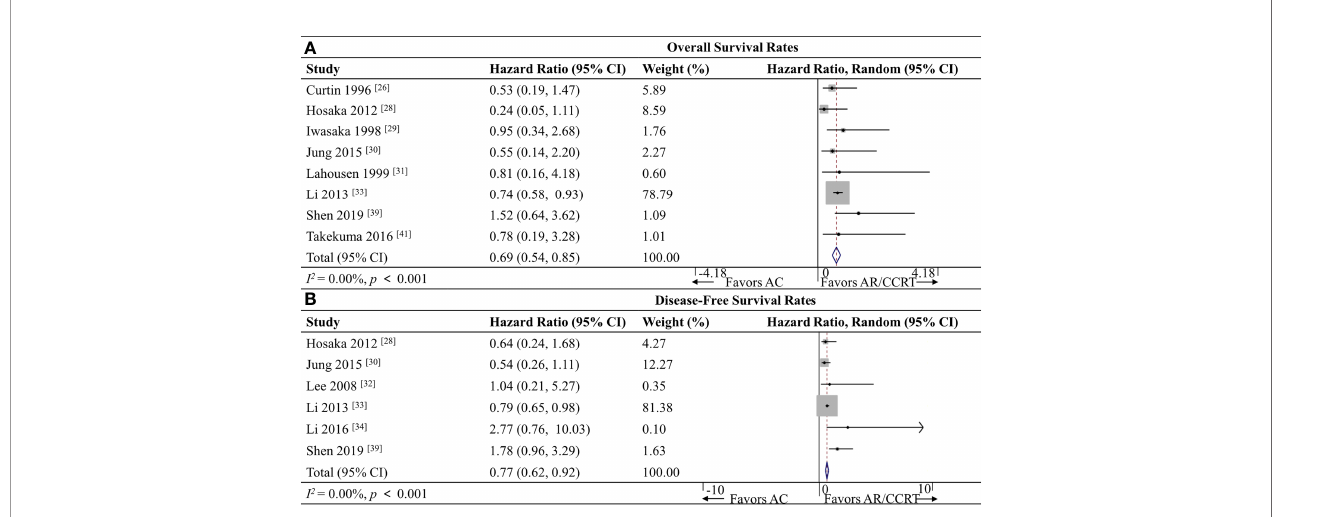
FIGURE 3 | Forest plot of the meta-analysis of (A) overall survival rates or (B) disease-free survival rates in AC and AR/CCRT groups. AC, adjuvant chemotherapy; AR, adjuvant radiotherapy; CCRT, concurrent chemoradiotherapy; CI, con fi dence